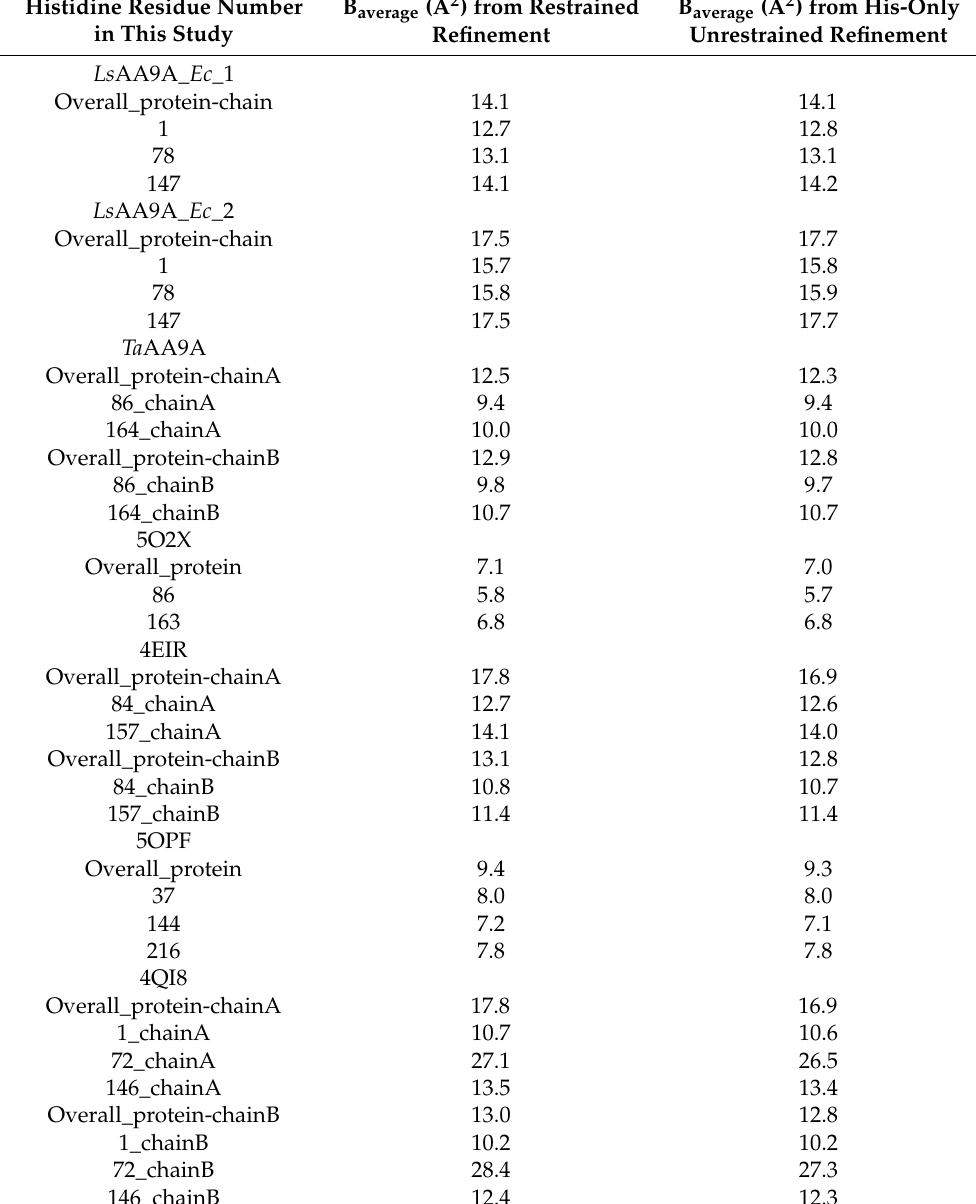
Table 4. Average B factors for overall protein structure and the His residues after restrained and His-only restrained